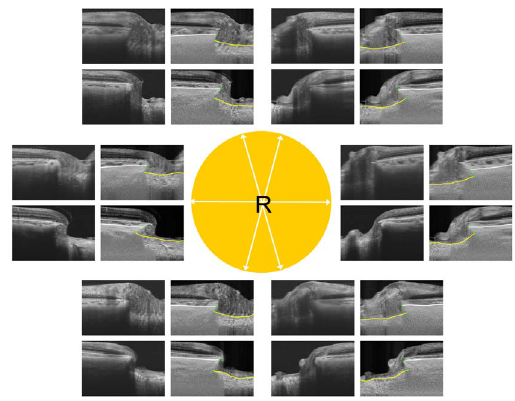
Fig. 4. Comparison of ALI positions between eyes from a patient with primary open-angle glaucoma (POAG) and a normal control (both aged 62 years). The images are for the right eye in both patients. White arrows in the central circle indicate the meridians of the scans. The upper and lower images in each pair are from the normal control and POAG eyes, respectively. Yellow lines indicate the lamina cribrosa surface and white lines indicate the choroidoscleral interface. Note that ALID is greater in the POAG eye, with the most prominent differences being observed in the superotemporal and inferotemporal